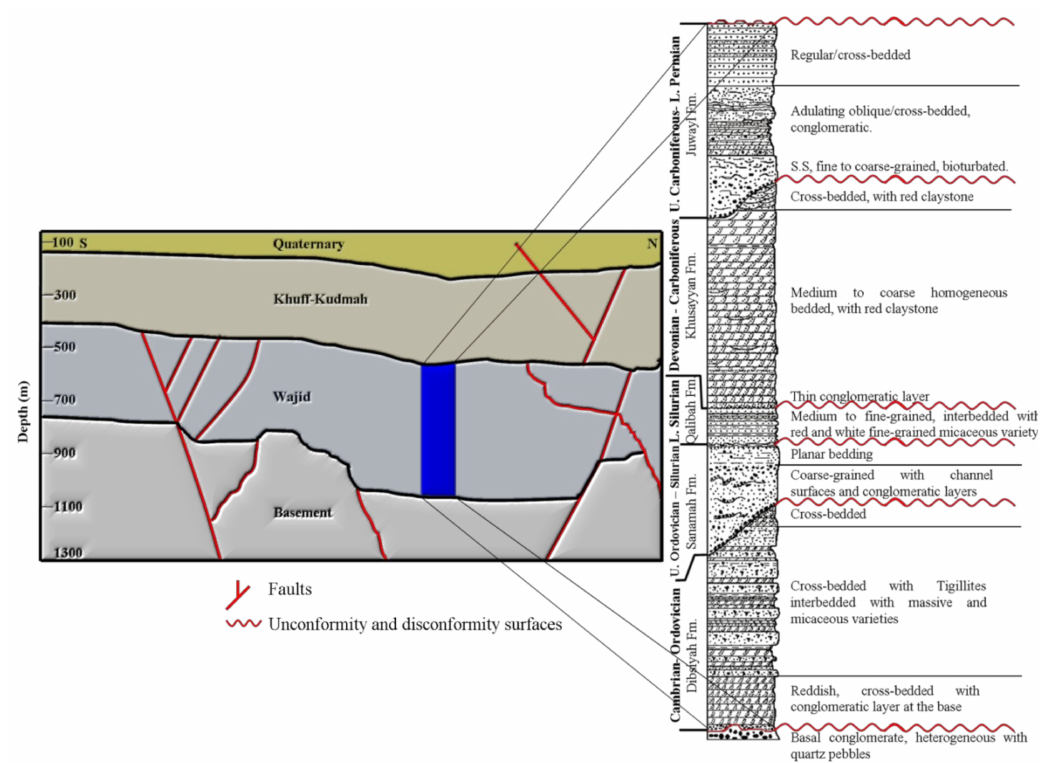
Figure 2. Stratigraphy and structures of the area (modified after Al Asmari et al., 2016 and Benaafi et al., 2019